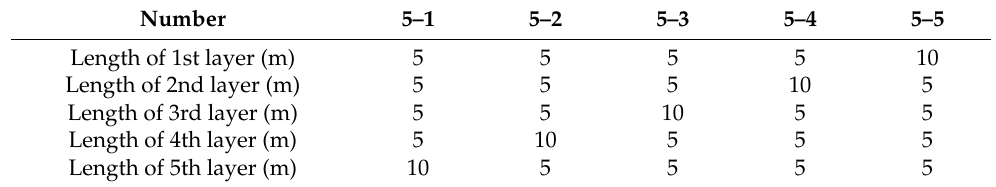
Table 4. Five types of five layers.